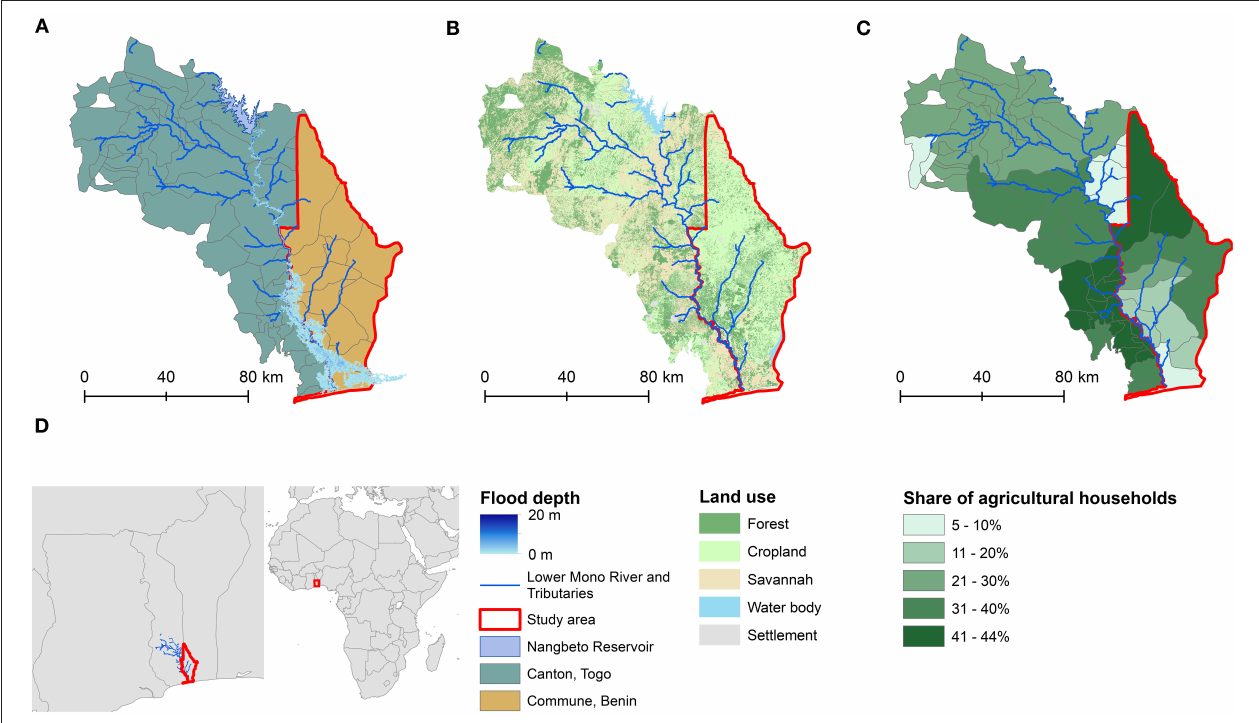
FIGURE 2 | Characteristics of the Lower Mono River Basin. (A) Extent of a 10-year return period flood hazard in the Lower Mono River Basin (Almoradie and Houngue, 2021), (B) land use in the Lower Mono River Basin (CENATEL - Centre National de Télédétection et de Suivi Ecologique, 2015; MEDDPN - Ministry of Environment Forest Resources, 2015 ), (C) share of agricultural households per administrative area (INSAE - Institut National de la Statistique et de l’Analyse Economique, 2016b; NSEED - Institut National de la Statistique et des Etudes Economiques et Démographiques et AFRISTAT, 2019), (D) location of Lower Mono River Basin in West